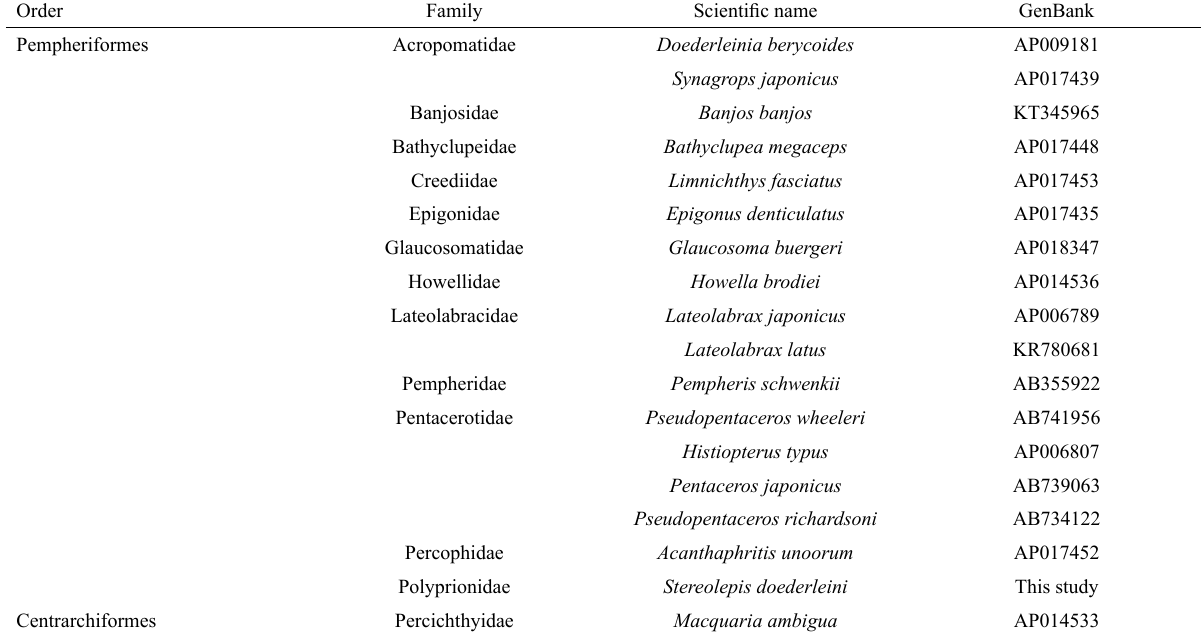
Table 1 – List of species used for phylogenetic analysis.